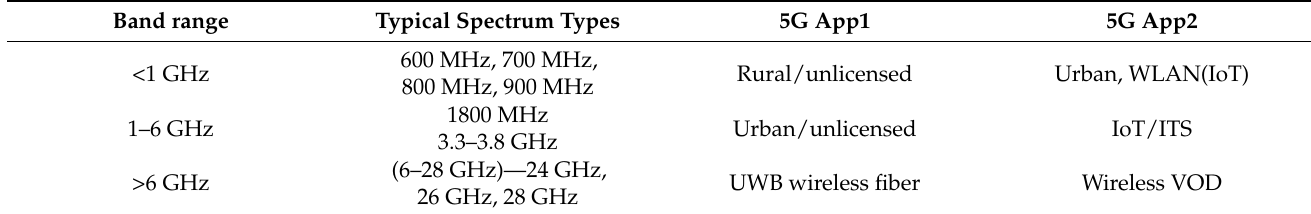
Table 1. The 5G spectrum bands and their applications